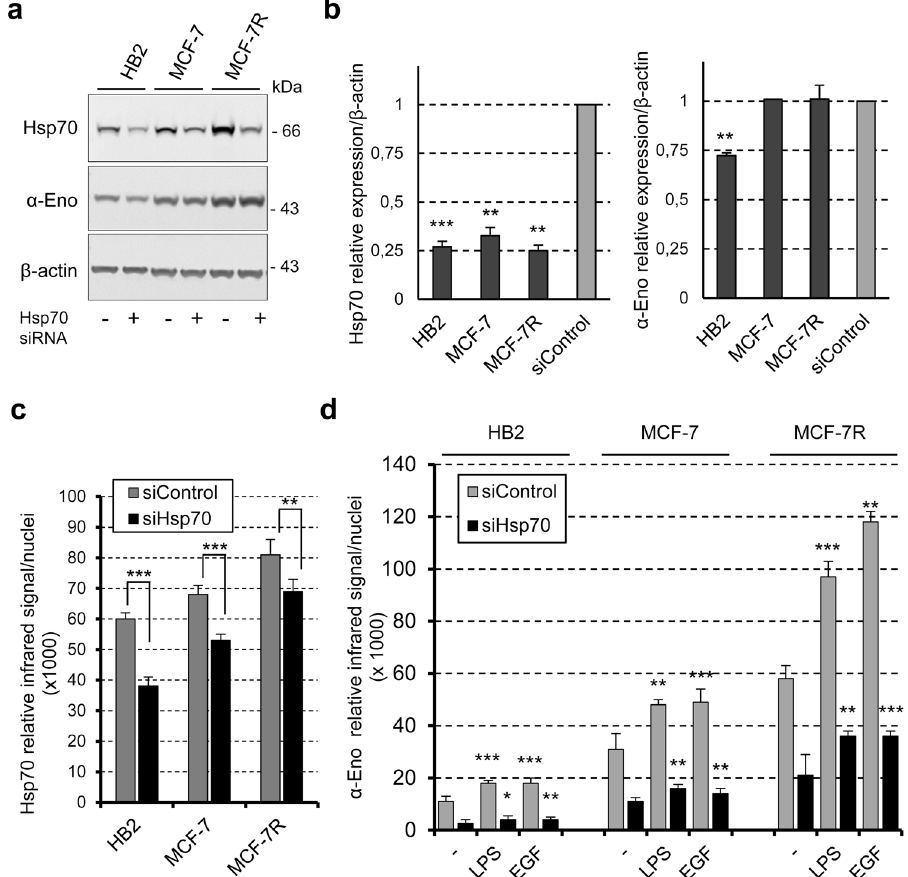
Figure 5. The knockdown of Hsp70 negatively affects surface-localized alpha-enolase. ( a ) HB2, MCF-7 and MCF-7R cells were treated with Hsp70-specific siRNA ( + ) or unrelated siRNA as a control ( − ), and immunoblotting analysis of total lysates with anti-Hsp70 and anti-alpha-enolase ( α -Eno) was performed. β -actin is shown as a control of the total proteins loaded per lane. ( b ) Quantification of Hsp70 and alpha-enolase in Hsp70-silenced cells. Data were normalised to the densitometric signals of β -actin and expressed relative to the level detected in cells treated with unrelated siRNA (siControl), set at 1. ( c , d ) Live on-cell western of Hsp70- silenced cells. The bar graph in ( c ) shows the relative mean infrared intensity for membrane Hsp70, corrected for nuclei staining. Transiently-silenced cells were either untreated or treated with 5 µ g/ml LPS or 0.1 µ g/ml EGF for 24 hours, and then analysed for the expression of surface-localized alpha-enolase by on-cell western ( d ). Results are the average of three independent experiments, error bars represent standard deviation and p values ( * P < 0.05, ** P < 0.01, *** P < 0.001) indicate statistical significance relative to the untreated